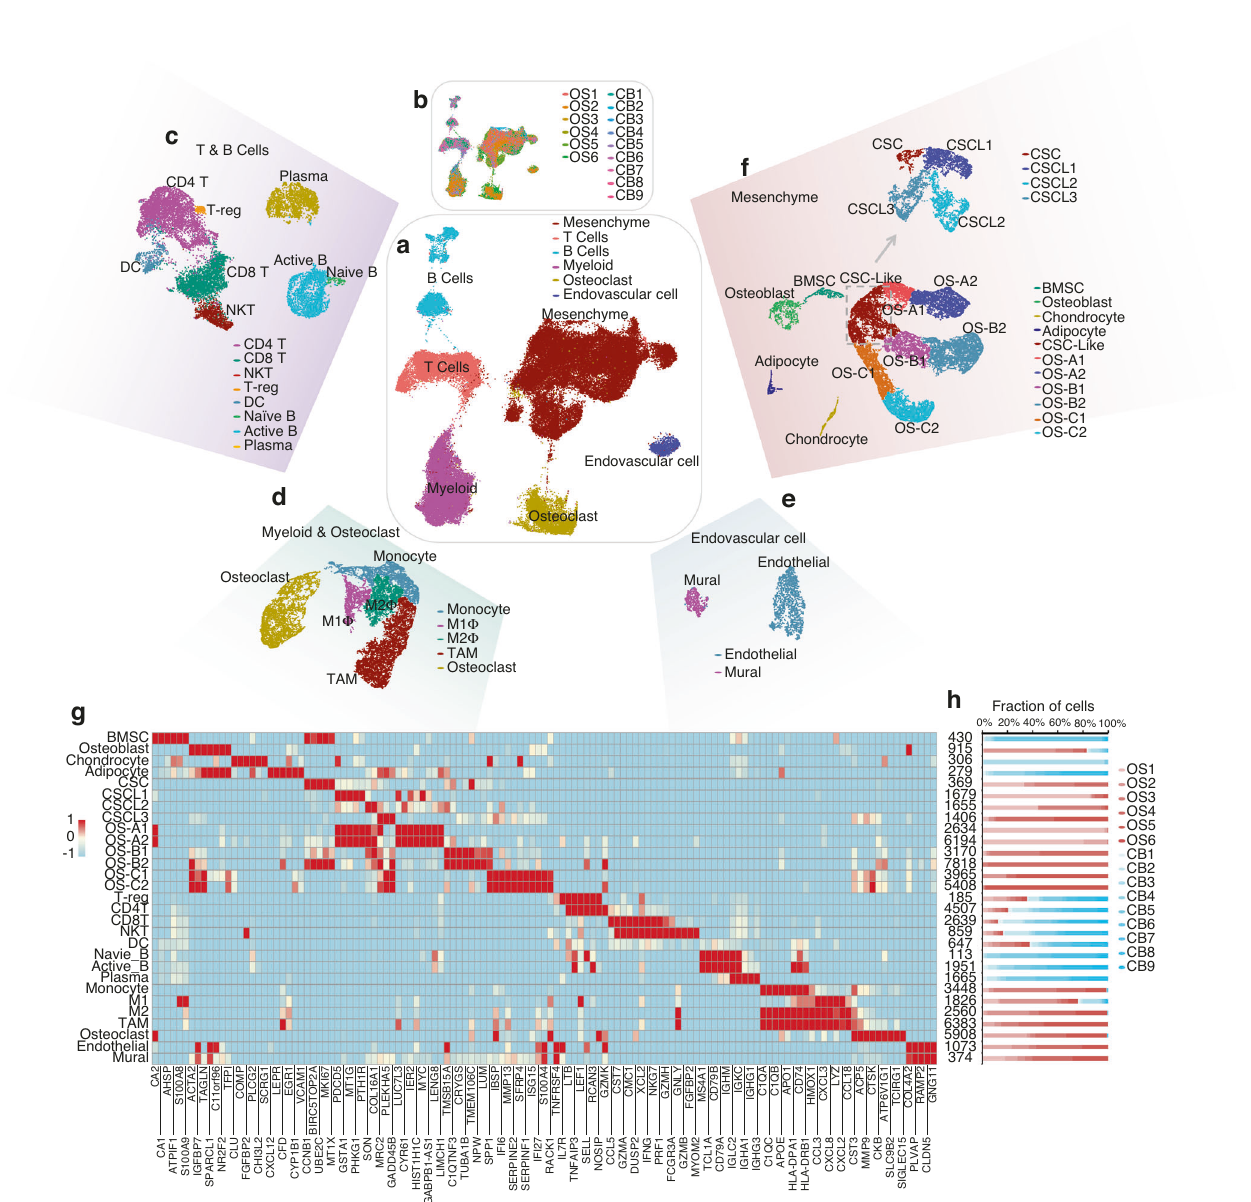
Fig. 1 Single-cell atlas of osteosarcoma (OS) and normal cancellous bone (CB) samples. a UMAP plot of OS and CB transcriptomes, color- coded for six phenotypes identi fi ed by graph-based clustering. b UMAP plot color-coded for each OS and CB sample. c UMAP plot of T and B cells, color-coded for eight phenotypes identi fi ed by graph-based clustering. d UMAP plot of myeloid cells, including osteoclasts color-coded for fi ve phenotypes. e UMAP plot of endovascular cells color-coded for two phenotypes. f UMAP plot of mesenchymal cells color-coded for 11 phenotypes and the UMAP plot of CSC-like clusters color-coded for 4 phenotypes. g Heatmap of expression of subset-speci fi c markers across cell subsets. h Reproducible cell subset distributions across samples. Fractions of cells in each cluster derived from OS (red) or CB (blue) samples are to the CNV calculation results based on scRNA-data, we found that pathway enrichment between the OS-A2/B2/C2 clusters, such as CSC-like cells had different CNVs compared with other OS clusters. activation of cell cycle- and ERBB2-related pathways in OS-B2 and In addition, the clusters in the same differentiation branch enrichment of bone resorption and immune activation pathways exhibited similar CNVs, but different differentiation branches in OS-C2 (Fig. 3f). Expression levels of target genes involved in had distinct CNVs. For example, extensive chromosomal gains targeted therapies were also diverse in the OS-A2/B2/C2 clusters. were observed in 6p, 8q, 16q, 17p, and 19p of branch-A clusters, For example, VEGFRs (FLT1 and KDR) and CDK4 were over- 3p, 6, 10, and 19 of branch-B clusters, and 3p, 9q, and 19 of expressed in the OS-B2 cluster, and PD-L1 (CD274) was branch-C clusters. Extensive chromosomal losses were found in 10, upregulated in the OS-C2 cluster (Fig. S2e). These results suggest 12q, and 19q of branch-A clusters, 8q, 12p, 14, 20, and 22 of that OS cells in distinct differentiation branches might be sensitive branch-B clusters, and 12q of branch-C clusters (Fig. 3h). These to different drugs. results highlight the heterogeneity between the three differentia- Differences in gene expression in cells are often caused by tion branches of tumor cells in OS. changes in chromosome copy number variation (CNV). According